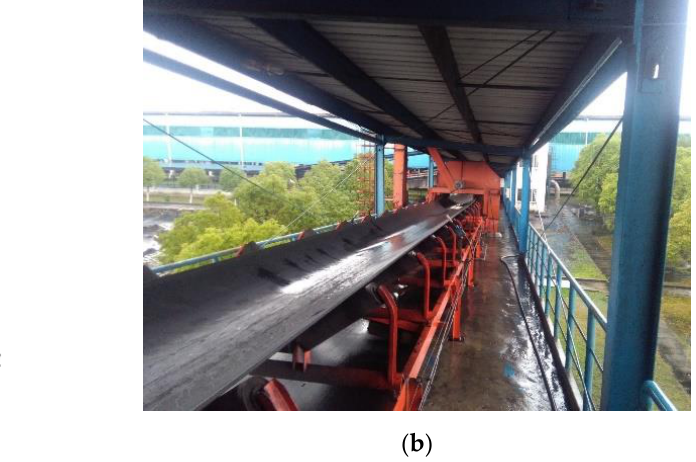
Figure 1. Coal mine belt conveyor: ( a ) illustration of model; ( b ) object pictures.